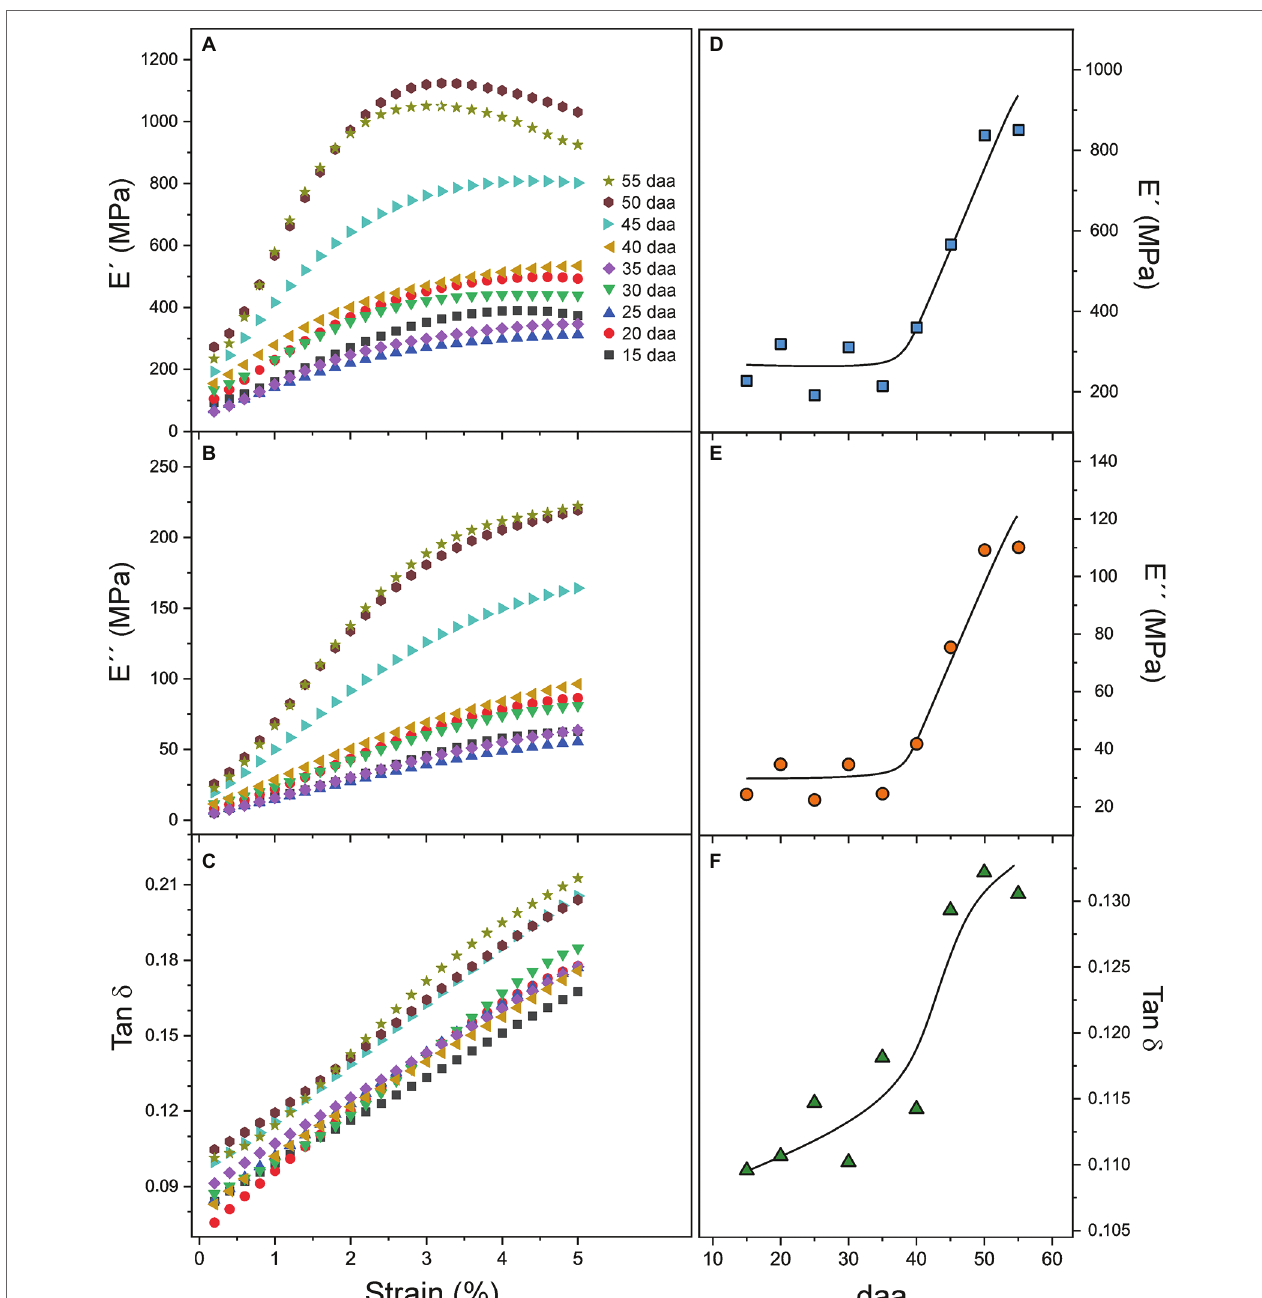
FIGURE 6 | (A–C) E ' , E '' , and Tan δ dependence with strain for tomato Cascada cuticles. (D–F) E ' , E '' , and Tan δ evolution with ripening